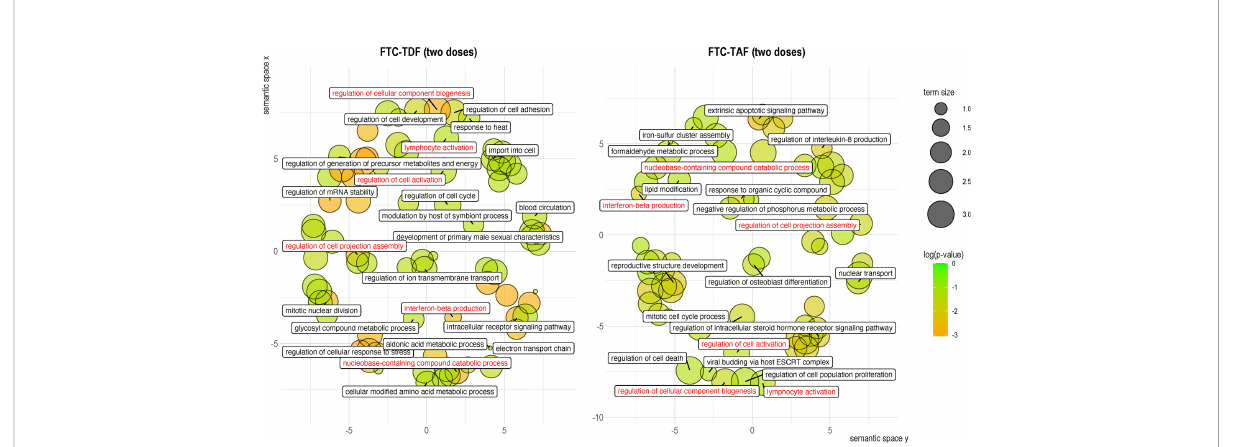
FIGURE 7 Clustering of gene ontology terms associated with DEGs in the merged drug and dose arms. GO associations with DEGs were established by using clusterPro fi ler to extract a single GO term for each DEG. The biological process GO terms associated with each of the identi fi ed DEGs were then analyzed using REVIGO and the semantic space clusters visualized for each PrEP regimen. GO terms are represented by circles, whose size indicates the relative number of genes included in the term. Circles are colored according to the signi fi cance (p-value) of the gene they represent. Labels correspond to the GO term determined to be representative of the cluster. Shared GO terms are shown in